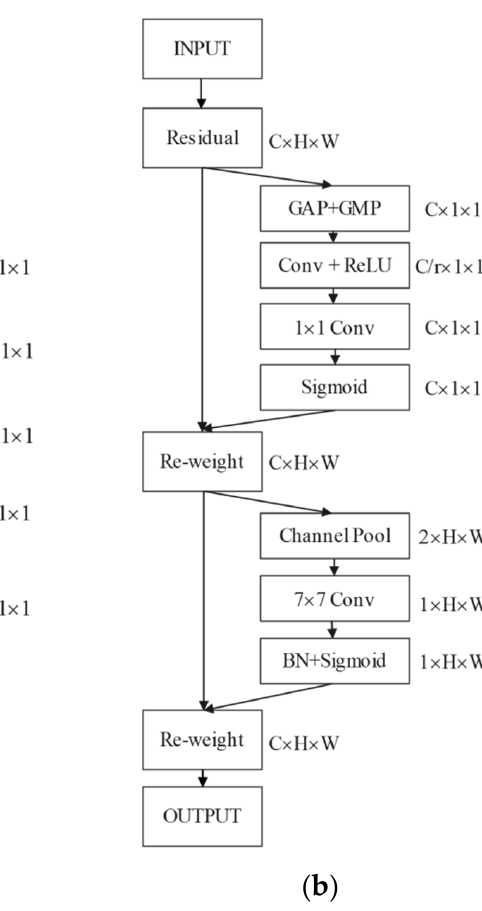
Figure 4. Schematic diagrams of two attention blocks. ( a ) the classic SE channel attention block [47]; ( b ) CBAM [37] attention block.